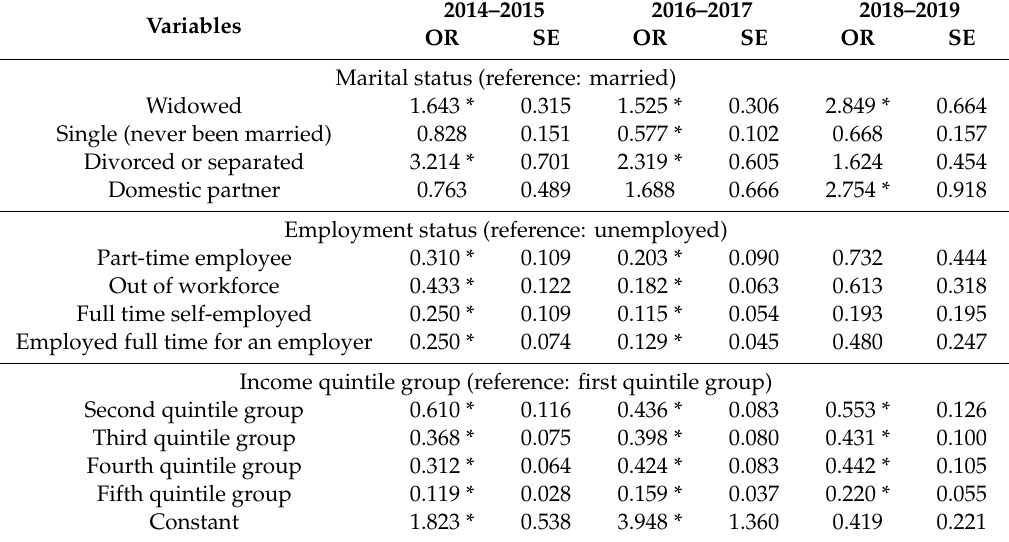
Table 5. Logistic regression models on food insecurity by set of variables including marital status and employment